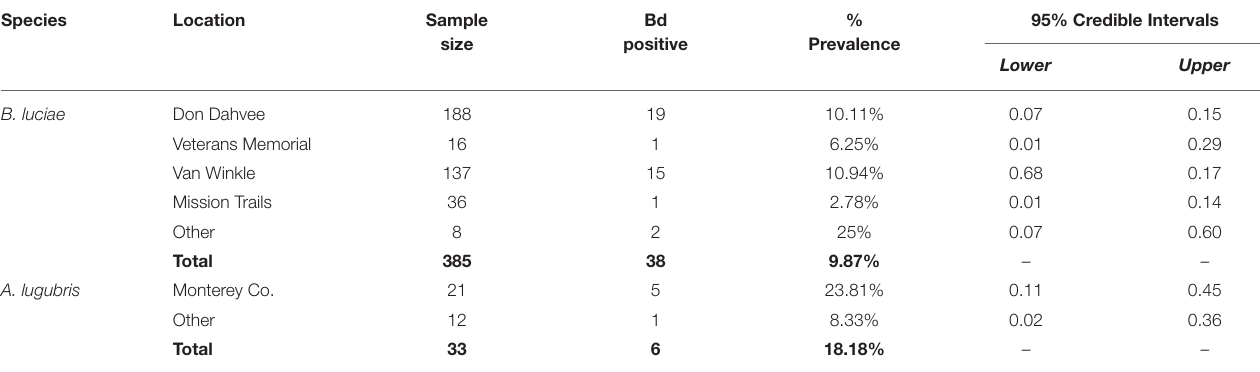
TABLE 2 | Batrachoseps luciae and Aneides lugubris field Bd prevalence by location, May 2014-March 2015.